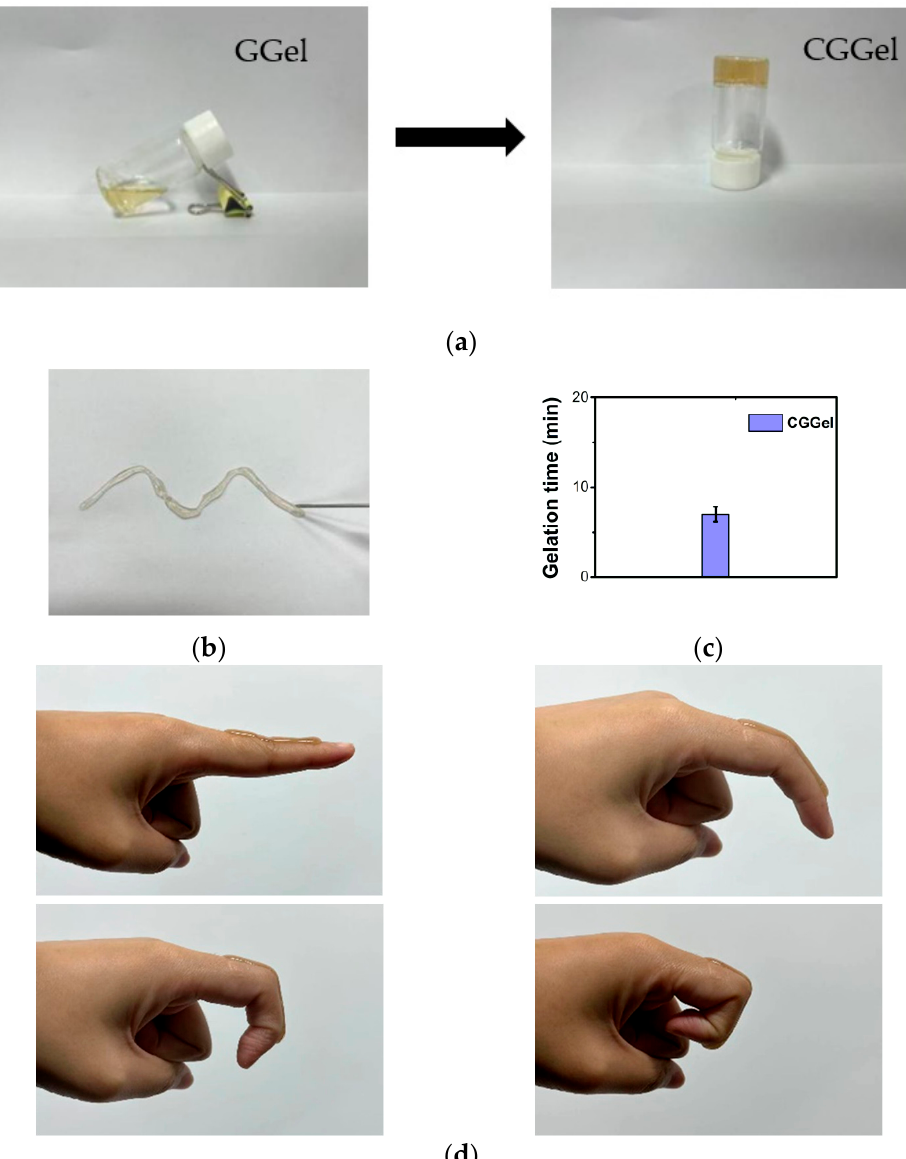
Figure 4. ( a ) Optical images of the gelation progress of the CGGel hydrogel. ( b ) The photograph showed the injectability of the CGGel hydrogel. ( c ) Gelation time of the CGGel hydrogel. ( d ) The CGGel hydrogel adhered to the skin of the author.